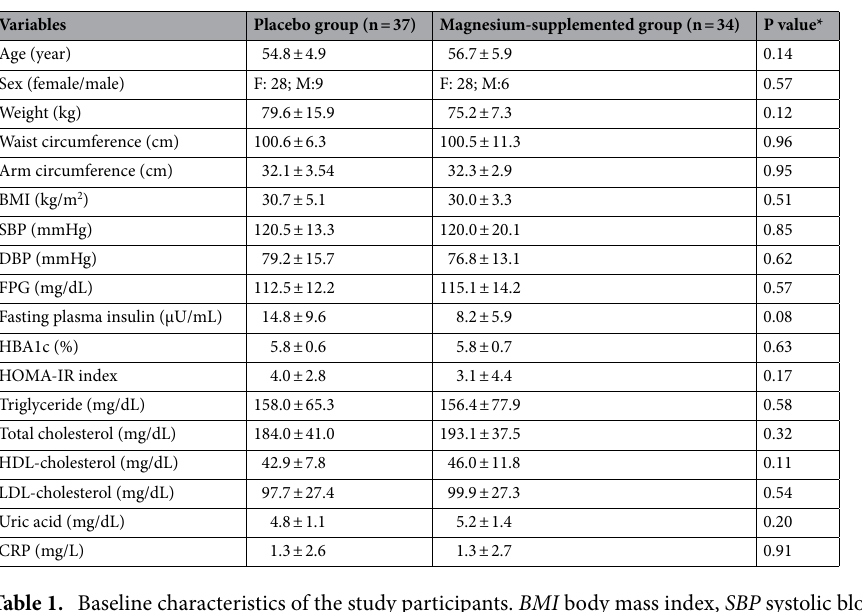
Table 1. Baseline characteristics of the study participants. BMI body mass index, SBP systolic blood pressure, DBP diastolic blood pressure, FPG fasting plasma glucose, CRP C-reactive protein. *Resulted from independent samples t-test for continuous and chi-squared for categorical variables.